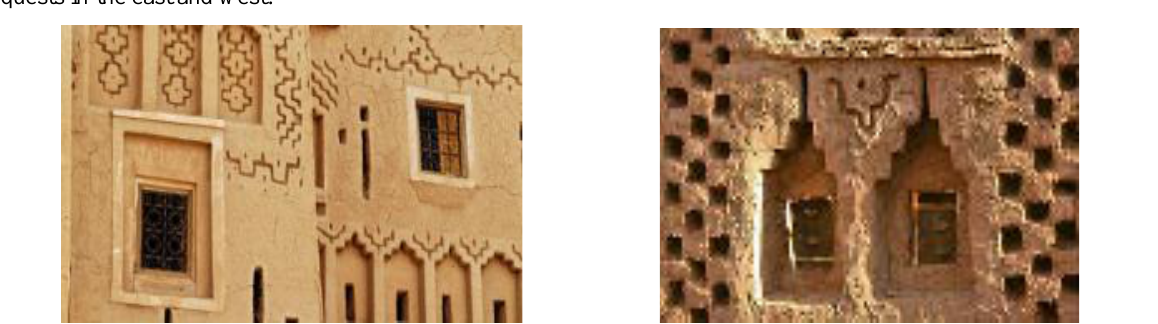
(Figure.3) some of the wall decorations in one of the facades of the Berber towns.